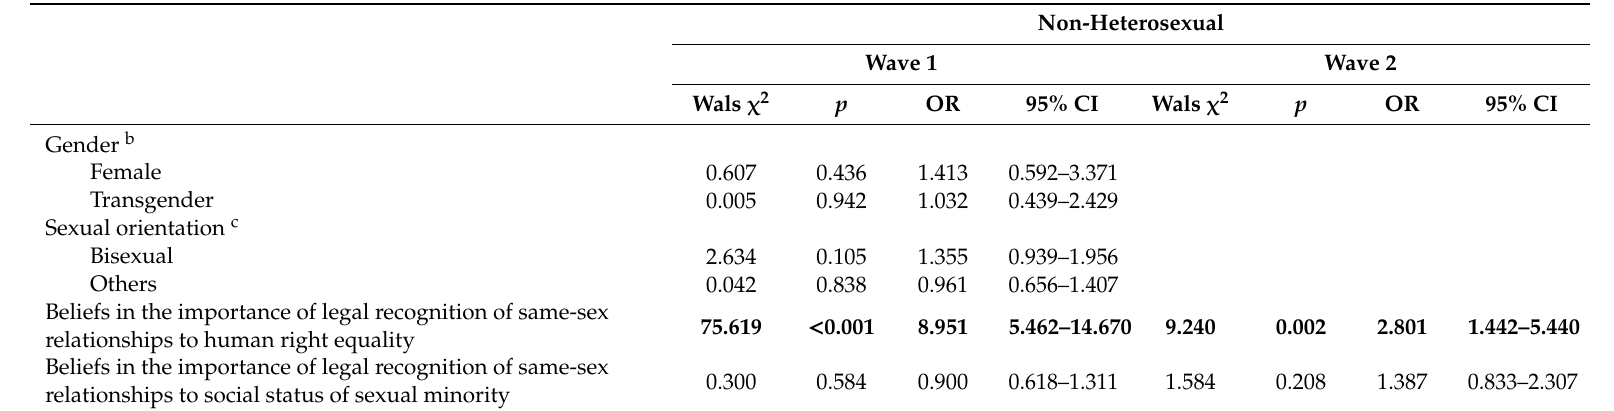
Table 6. Factors related to preference of establishing same-sex marriage law in the Civil Code among non-heterosexual participants supporting the legalization of same-sex relationships in Wave 1 and Wave 2 a